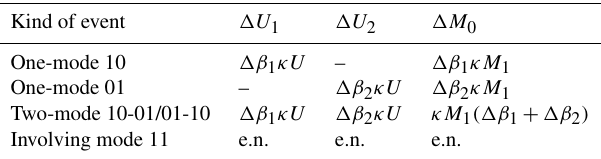
Table 2. Changes in the final slip amplitudes U 1 and U 2 of asper- ity 1 and 2 and in the seismic moment M 0 associated with the dif- ferent seismic events predicted by the model, after a stress pertur- bation from neighbouring faults. The entry e.n. is the abbreviation for evaluated